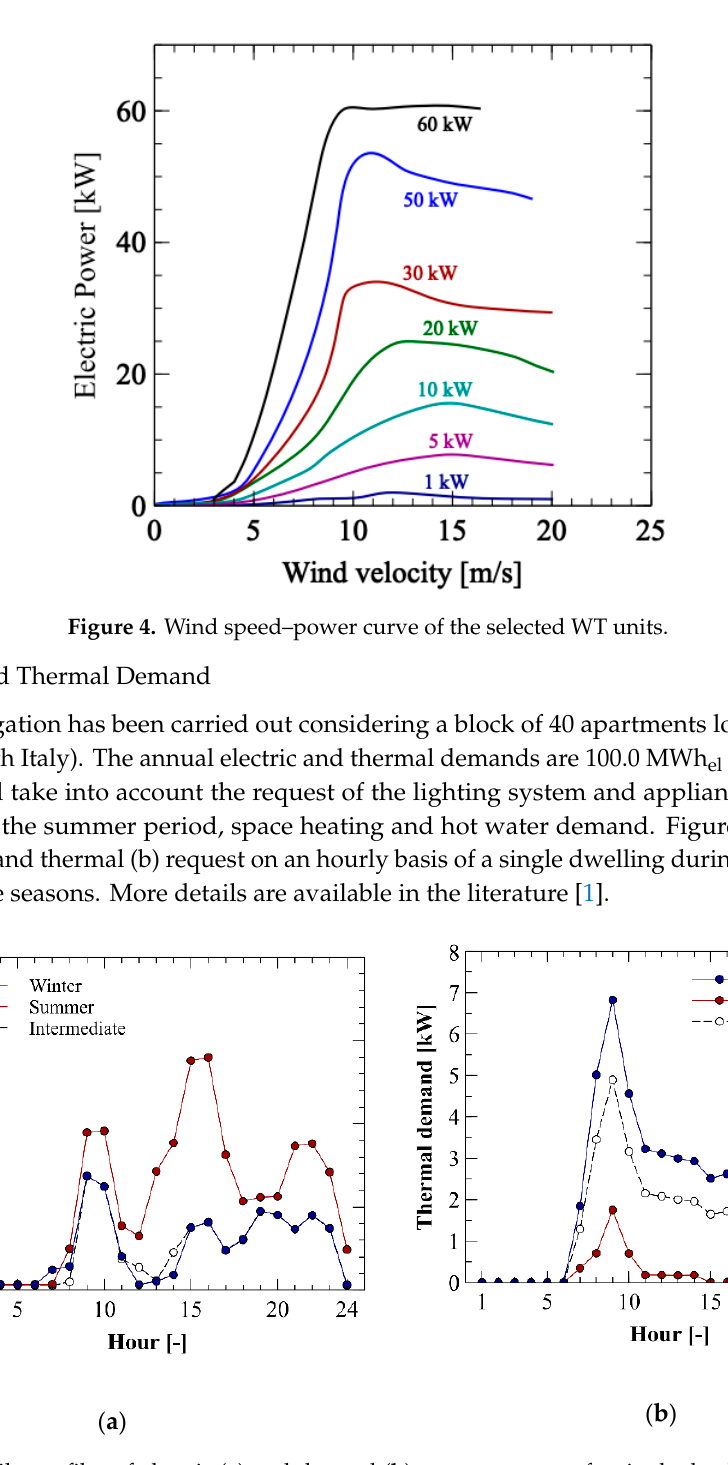
( b ) Figure 6. Hourly global irradiance ( a ) and wind velocity ( b ) in Palermo (Italy). 2.3. Optimal Integrated System Configuration A multi-variable optimization has been carried out to define the most suitable configurations and operating conditions of the multi-source integrated CHP system (components and corresponding nominal power). In this work, the payback period ( t ), electric self-consumption ( S ) and surplus ( s ) have been considered as optimization parameters (“t-S-s approach”) in order to find a suitable compromise between economic and energy requirements. To this purpose, authors adopted the “minimum distance” method according to the literature [63,64]. The technique recommends selecting the combined system arrangements that minimize the dimensionless distance to the ideal point that is defined by the minimum payback period ( t min ), the maximum self-consumed electric energy ( S max ) and the minimum electric surplus ( s min ), according to: